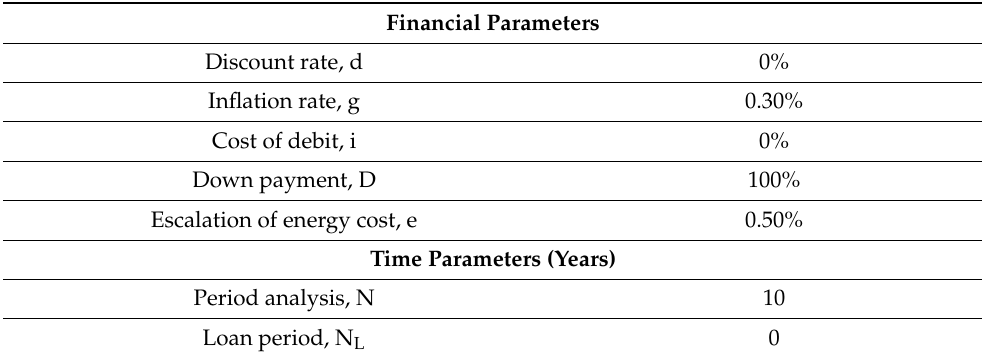
Table A2. Economic and time parameters for the calculation method of LCCA